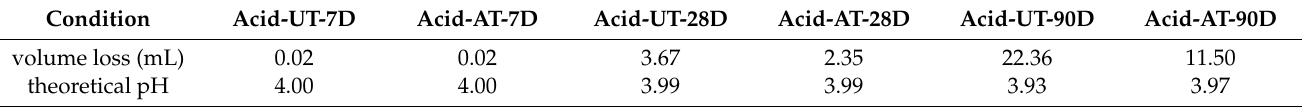
Table 3. Volume loss and calculated theoretical pH value of acid rain under different conditions.